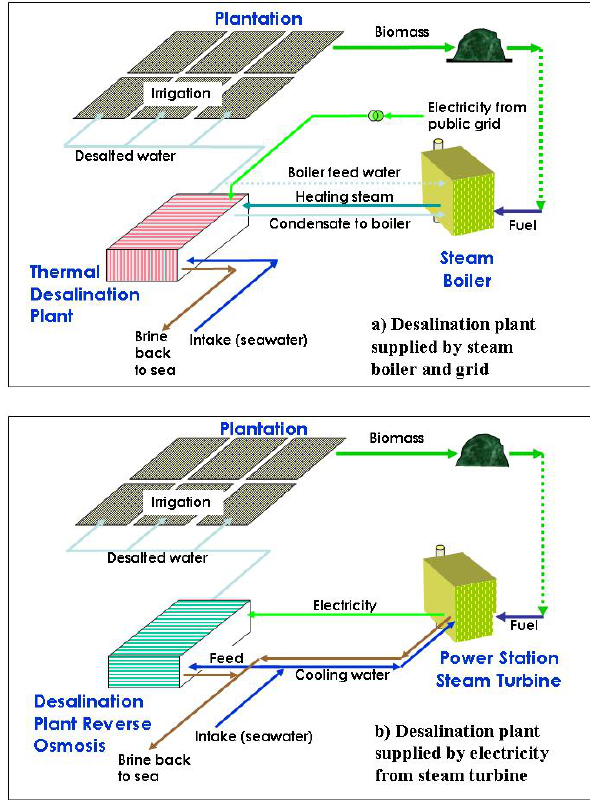
Fig. 3. Two methods for removing salt from Fig.3 Two methods for removing salt from seawater. 10